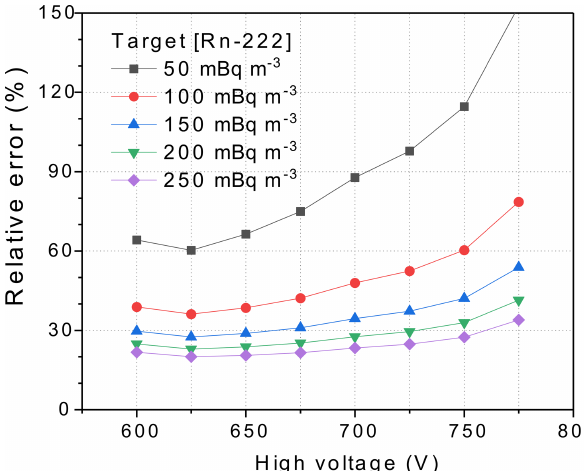
Figure 4. Relative counting error as a function of HV for a range of hypothetical radon activity